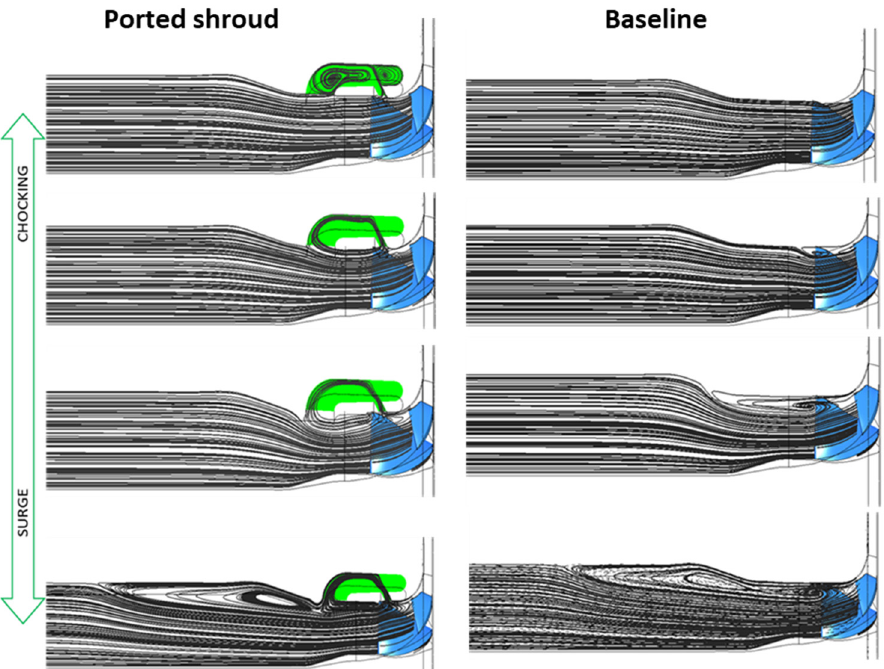
Figure 8. Streamlines on the meridional plane for different operating points in the configuration with ported shroud ( left ) and baseline ( right ), at Ncor = 1.0.